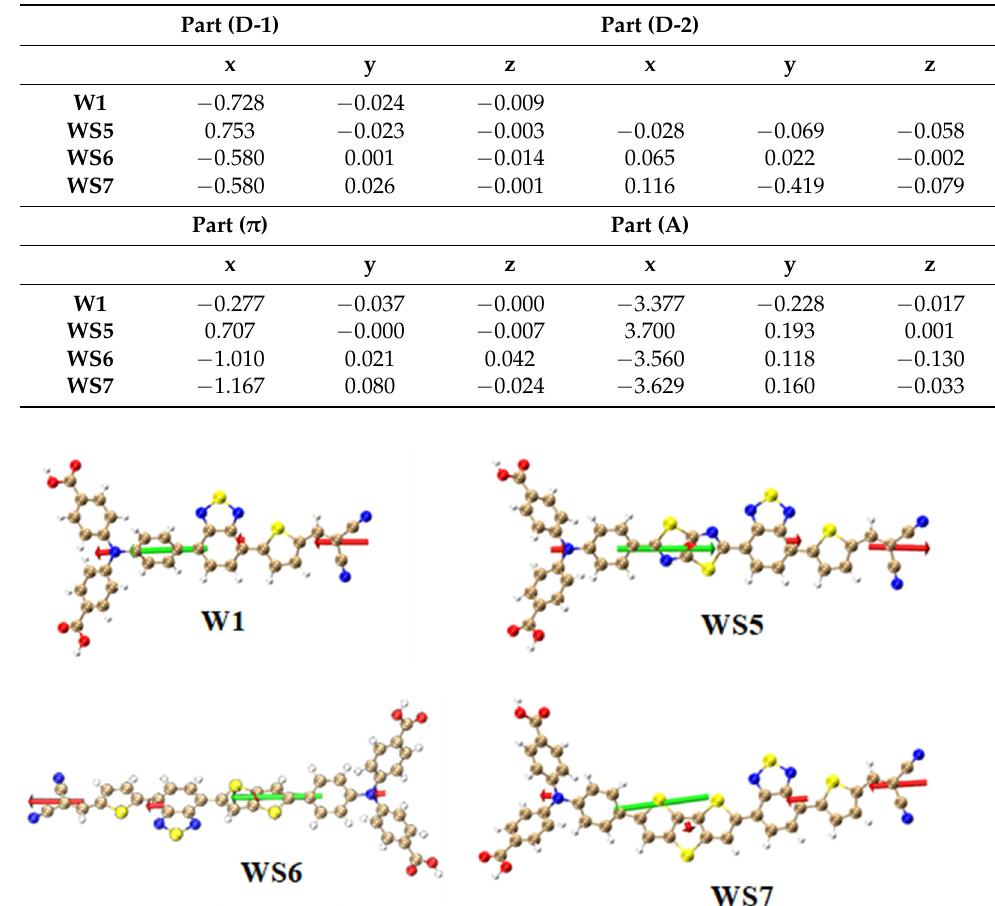
Table 3. Contribution of fragment to the transition dipole moment of the excited state S 1 (a.u.).